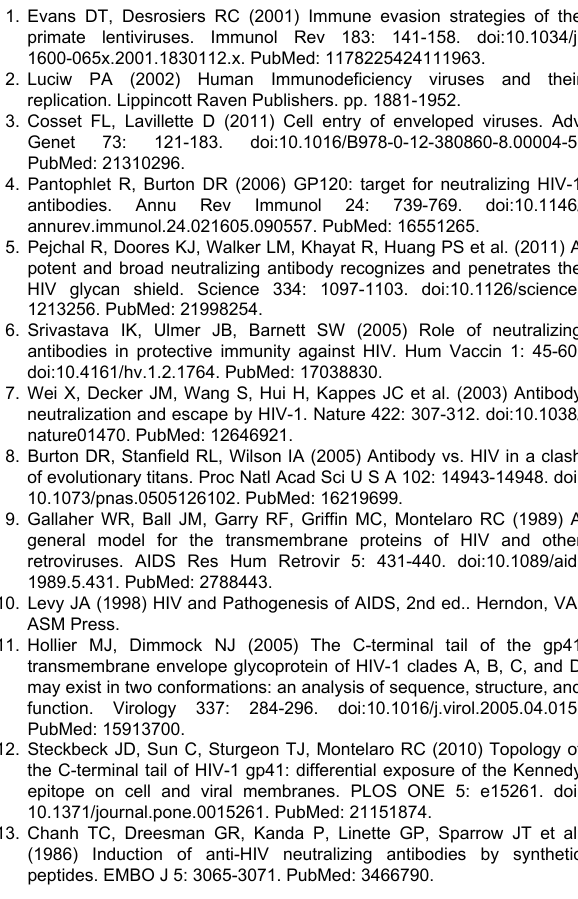
Table S1. List of primers. The sequences of the forward and reverse primers used to generate the different constructs are